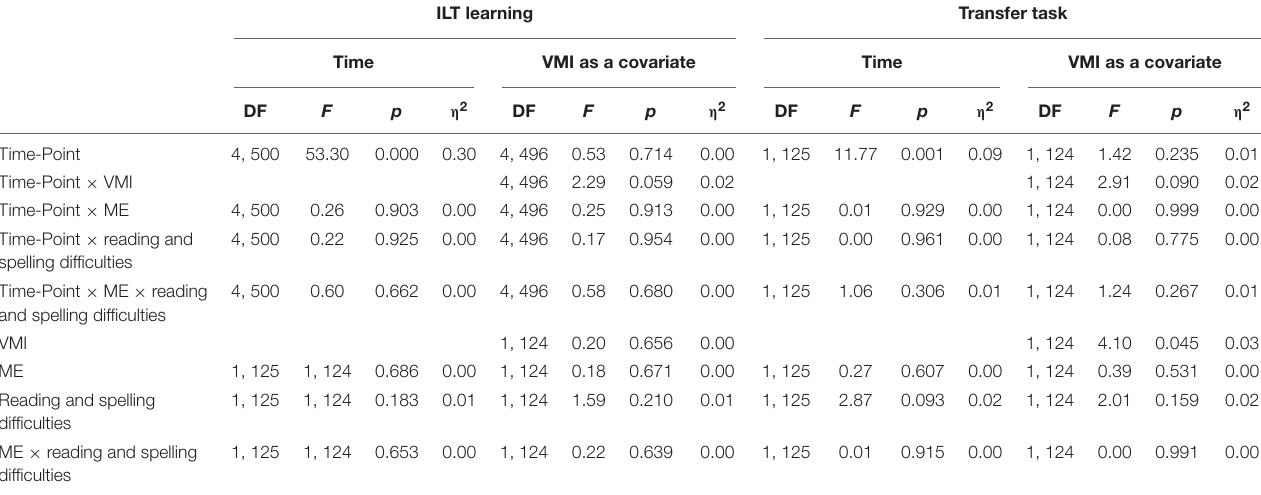
TABLE 4 | Analyses of ILT completion times.